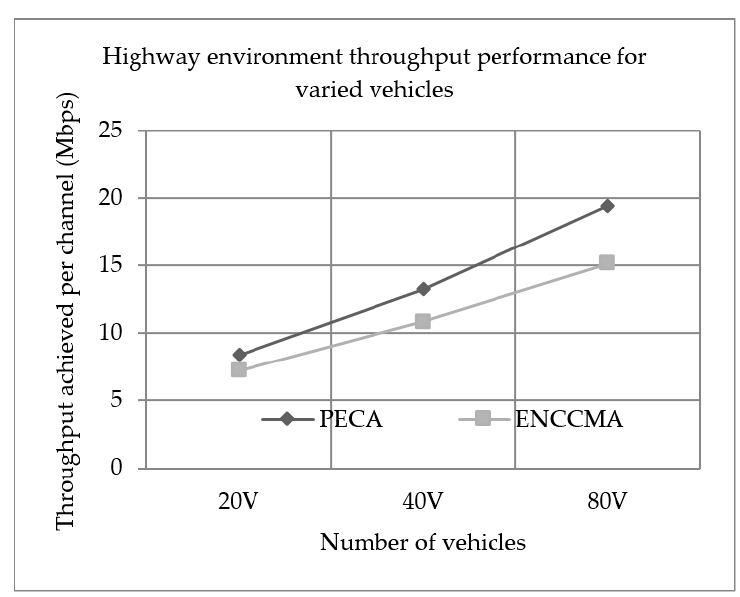
Figure 2. Highway environment throughput performance for varied vehicles.